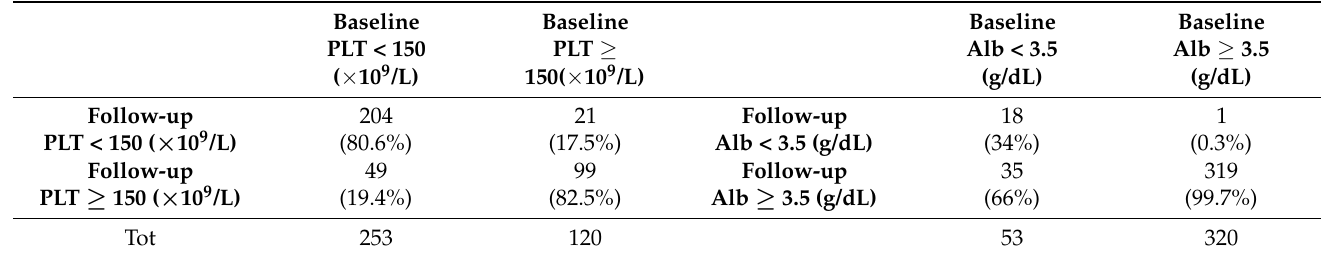
Table 2. The proportion of patients who had improved or worsened indirect signs of portal hyper- tension and hepatic synthesis as described by the cut-offs for the platelet count and albumin levels (150 × 10 9 /L and 3.5 g/dL, respectively) Alb—albumin levels; PLT—platelet count.